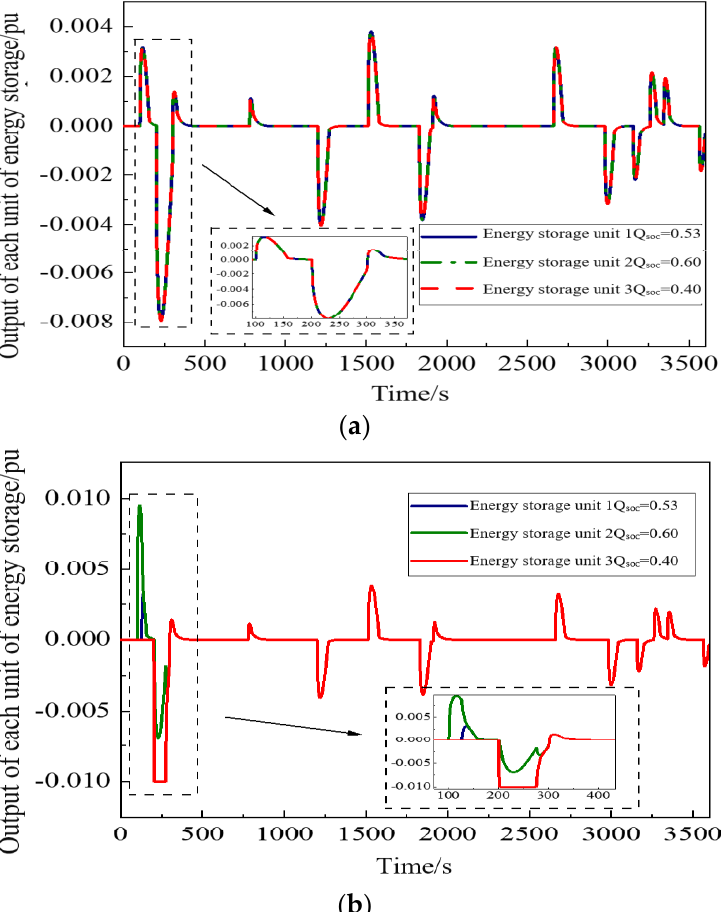
Figure 7. Output of energy storage unit under two distribution methods. ( a ) Output of each unit of the energy storage system evenly distributed by capacity. ( b ) Output of each unit under the proposed optimization method.